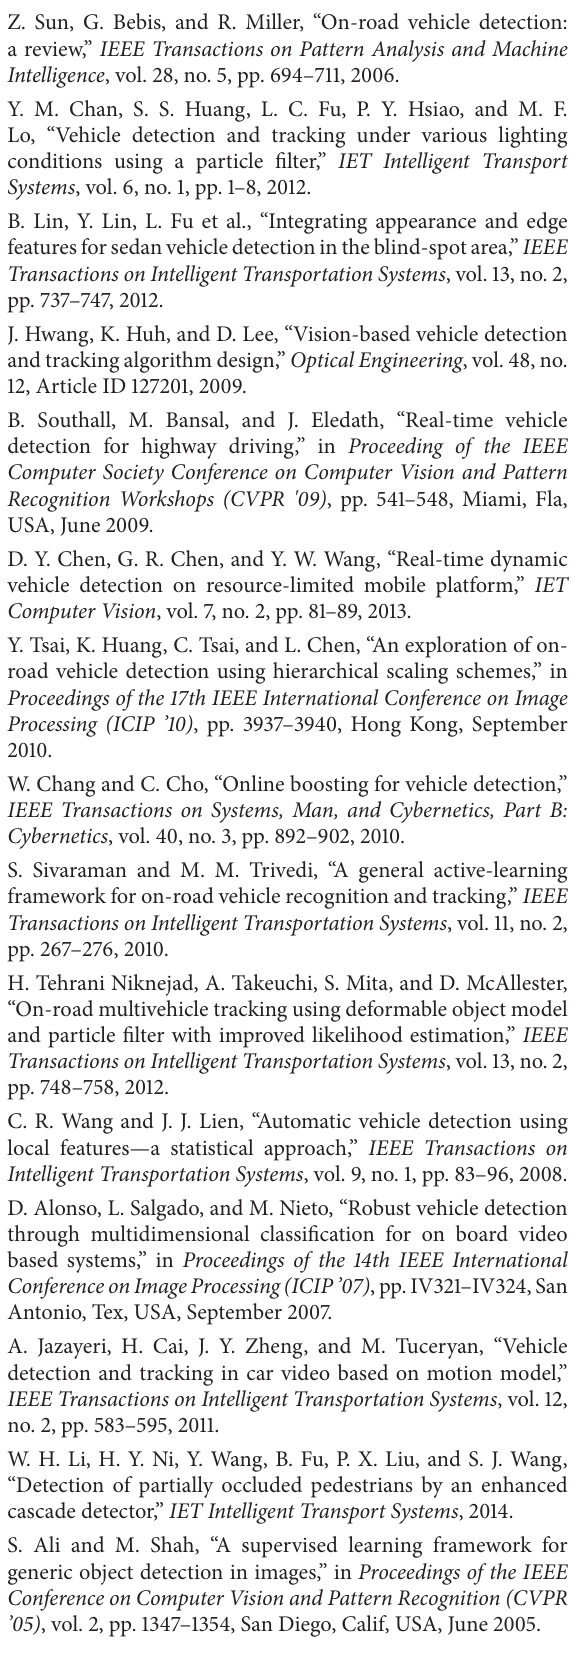
Table 2: Algorithm